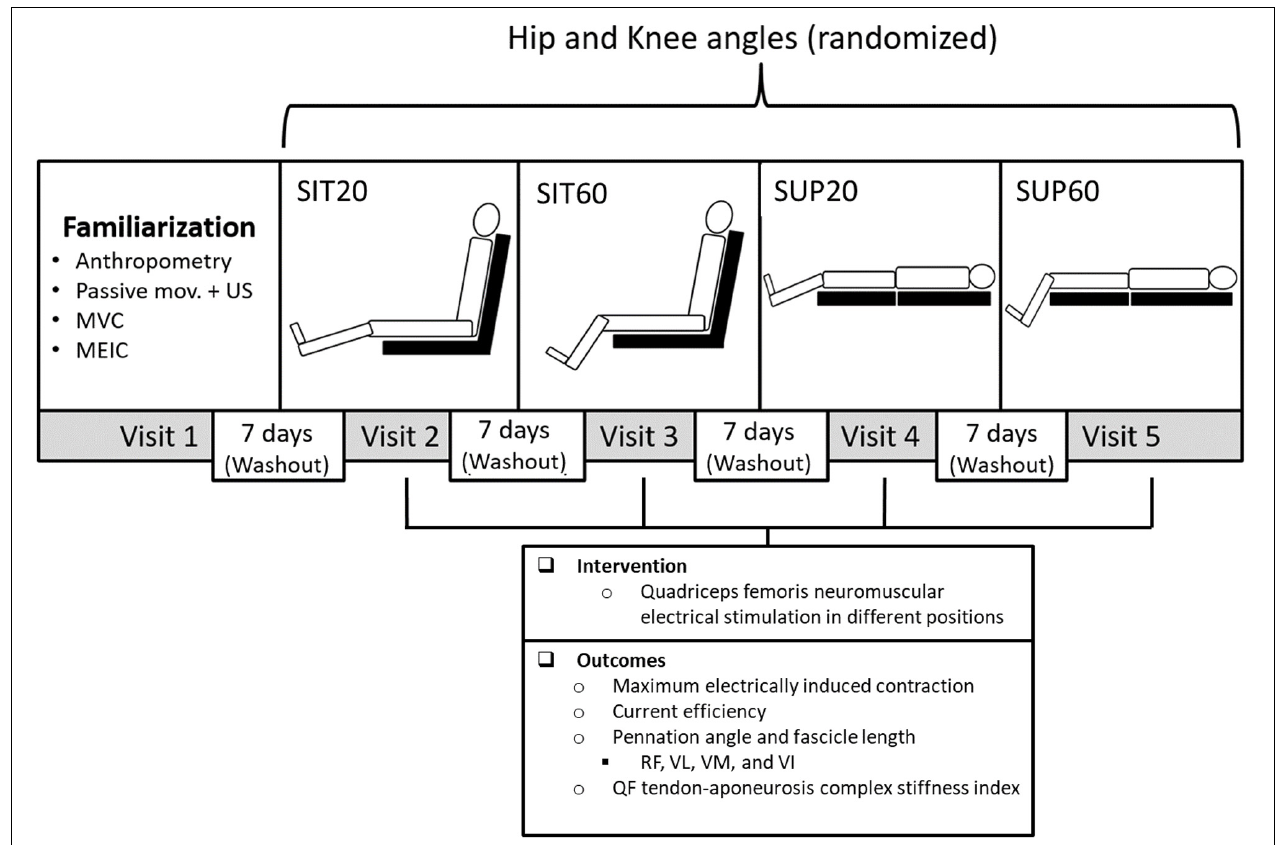
FIGURE 1 | Experimental design: Participants took part in five sessions each at least 7 days apart: A familiarization and four experimental sessions to test four different combinations of hip and knee joint angles randomly during quadriceps femoris (QF) NMES. In the familiarization session, participants underwent anthropometric measurements, QF ultrasound imaging (US) during passive knee movement, MVC practice, and MEIC. In each experimental session, eight MEIC were required. The primary outcomes were the MEIC (absolute and normalized by the MVC) and the current efficiency (MEIC/current amplitude). The secondary outcome was the muscle architecture at rest and during NMES (pennation angle and fascicle length) of all QF constituents and the QF tendon-aponeurosis complex stiffness index. NMES, neuromuscular electrical stimulation; SUP60, supine with 60 ◦ of knee flexion; SIT60, seated with 60 of knee flexion; SUP20, supine with 20 ◦ of knee flexion; SIT20, seated with 20 ◦ of knee flexion, where supine was 0 ◦ of hip extension, seated was 85 ◦ of hip flexion, and full knee extension; RF, rectus femoris; VL, vastus lateralis; VM, vastus medialis; VI, vastus intermedius; MVC, maximum voluntary contraction; MEIC, maximum electrically induced